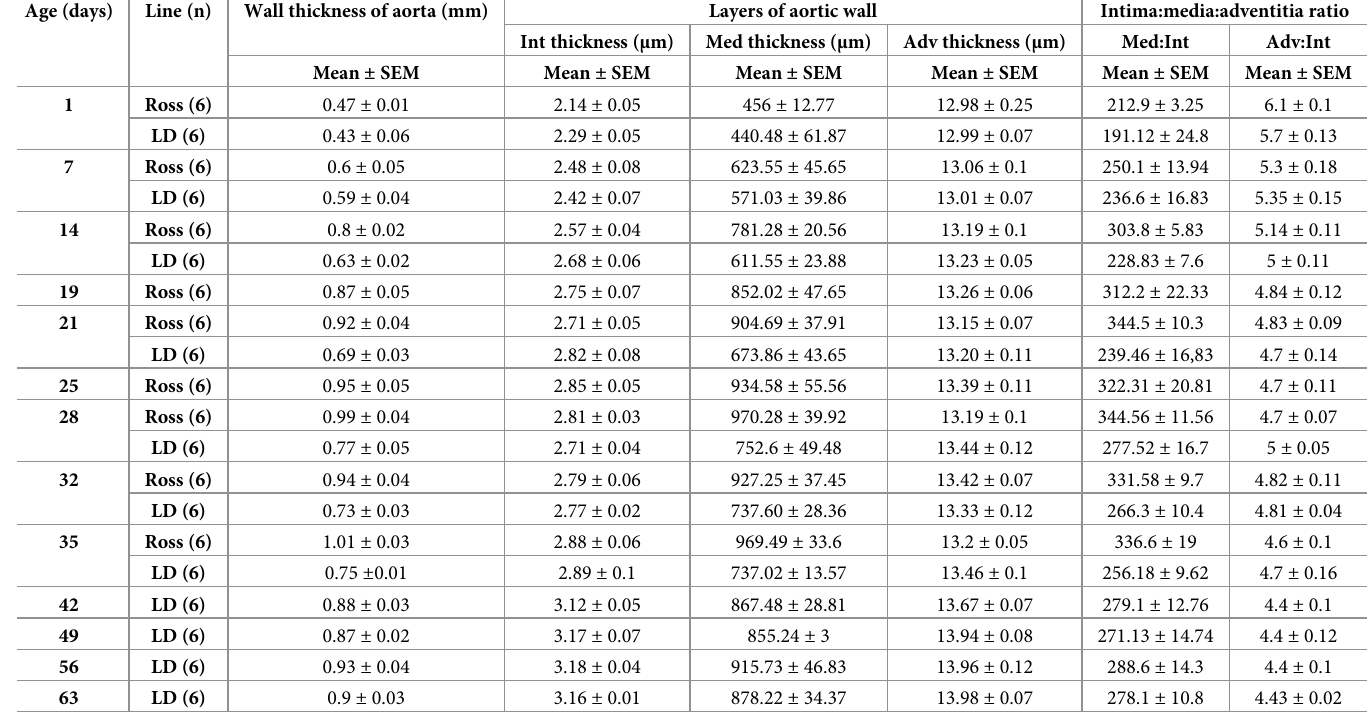
Table 4. Aortic wall measurements over time of LD and Ross chicken